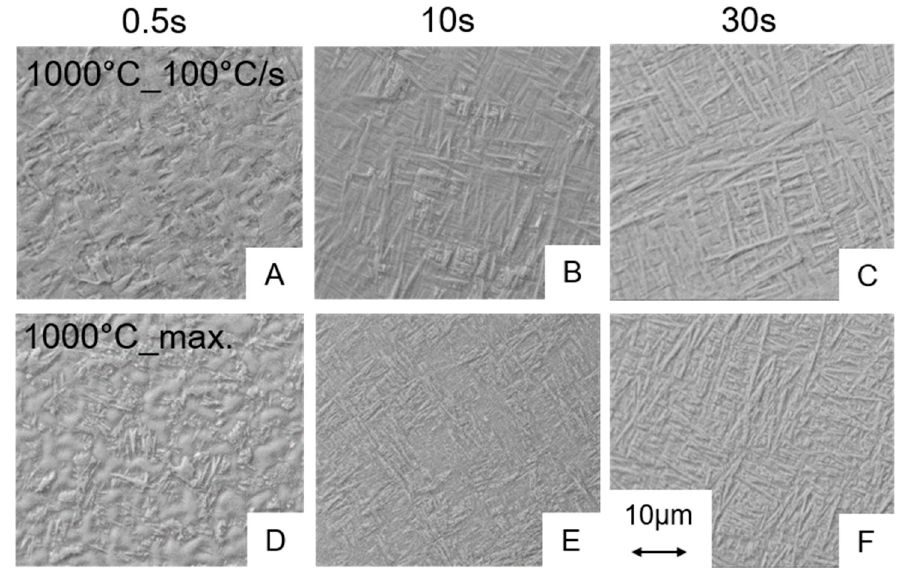
Figure 8. SEM images of the microstructures for the experiments at 1000 °C for holding times of 0.5, 10 and 30 s in combination with controlled cooling with 100 °C/s ( A – C ) and with the maximum cooling rate ( D – F ). The heating rate was 1000